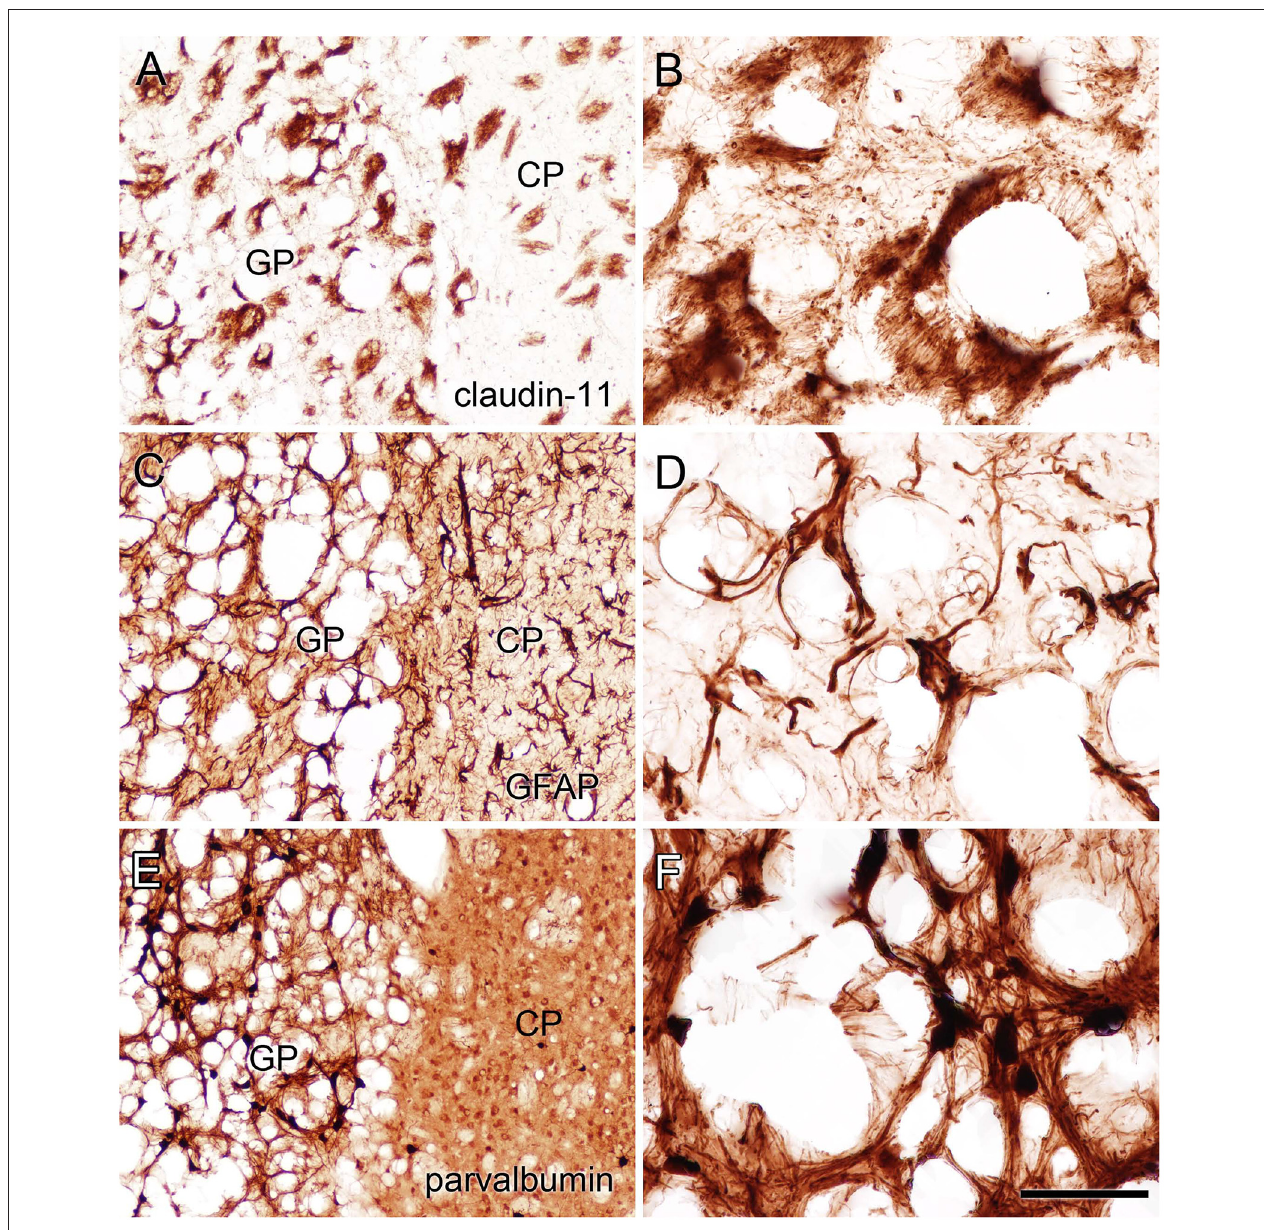
FIGURE 9 | Staining for claudin-11 (oligodendrocytes; A,B ), GFAP (astrocytes; C,D ) and parvalbumin (neurons; E,F ) showed that all three cell types remained in heavily vacuolated areas such as the GP. Higher magnification images in (B,D,F) are from heavily vacuolated areas in the GP (extended depth of field). Micron bar = 200 µ m (A,C,E) , 50 µ m (B,D,F)